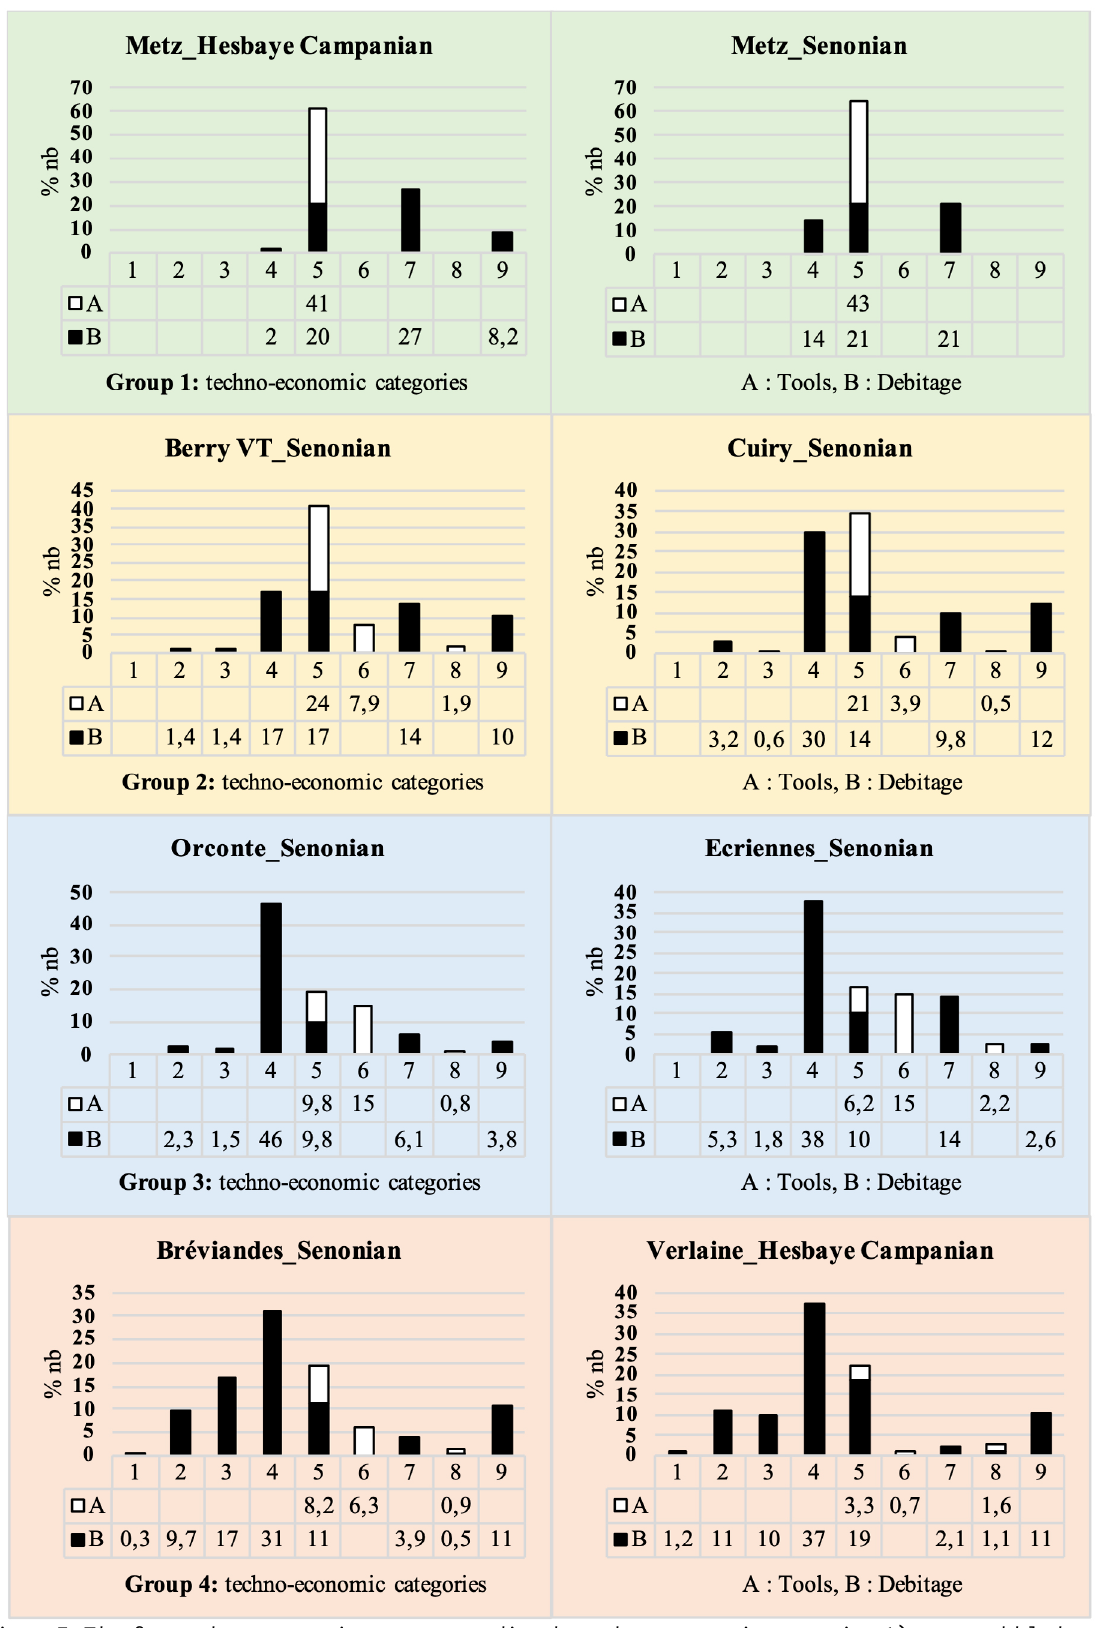
Figure 7. The four techno-economic groups according the techno-economic categories: 1) untreated blocks, 2) cortical flakes, 3) preparation flakes detached by hard hammer percussion, 4) flakes detached by indirect percussion, 5) blades and blade tools, 6) flake tools, 7) tool fabrication waste-products, 8) cores and hammers, 9) not